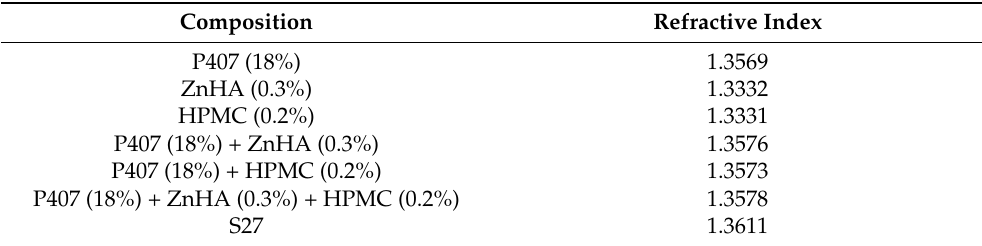
Table 3. Refractive index values of the compositions.